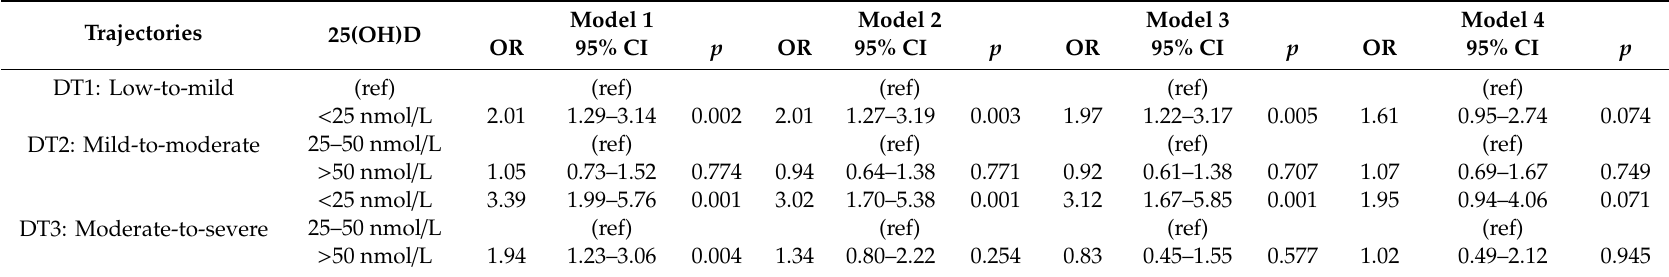
Table 2. Association between 25(OH)D concentration and disability